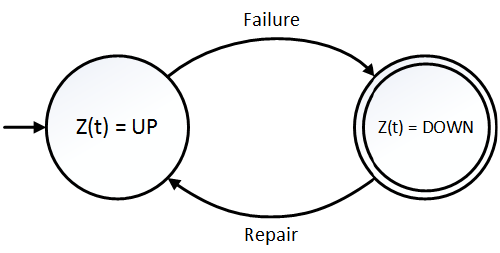
Figure 2. States of a repairable